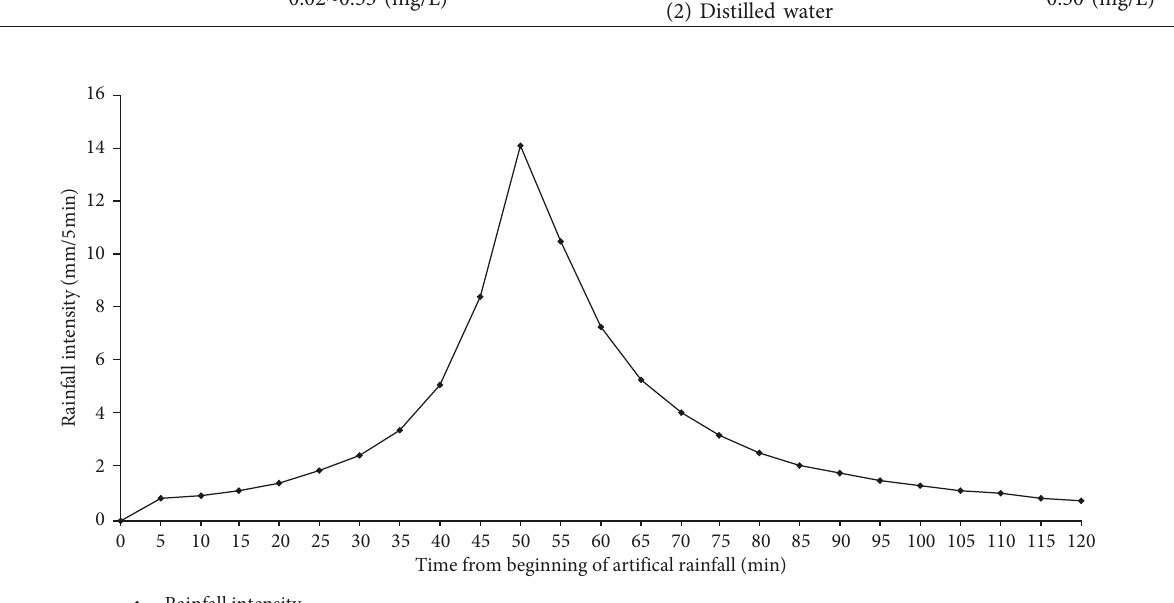
Figure 4: Rainfall storm designed according to the local conditions of Nanjing City (return period � 5years; r � 0.4; duration � 120minutes).